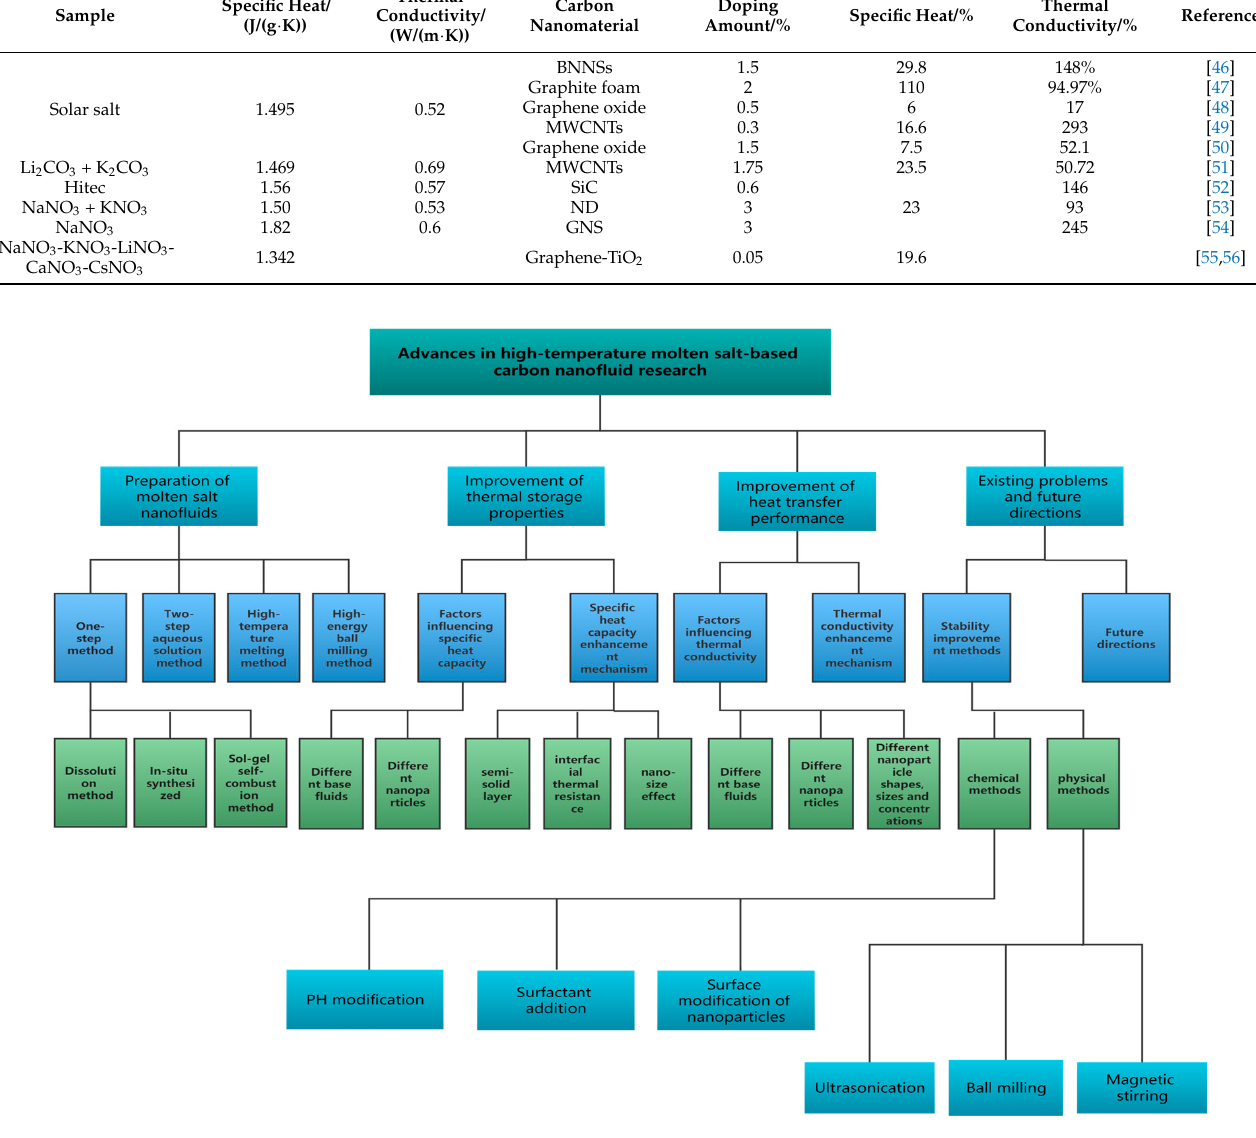
Figure 1. Schematic of research progress in high temperature molten salt-based carbon nanofluids. Table 1. Improvement of heat storage and heat transfer properties of nano carbon materials.